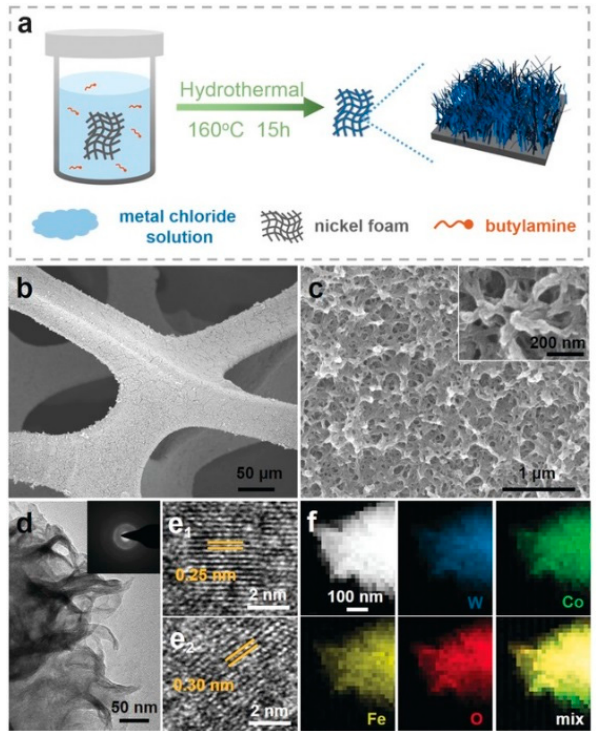
Figure 25. Preparative route ( a ) and morphological characterization of oxyhydroxides on nickel foam (NF): ( b , c ) SEM, ( d ) TEM and ( e 1 , e 2 ) HRTEM images of oxyhydroxide W 0.5 Co 0.4 Fe 0.1 /NF (inset: corresponding SAED pattern). ( f ) HAADF ‐ STEM image and STEM ‐ EDS mapping of W 0.5 Co 0.4 Fe 0.1 /NF (Co = green, Fe = yellow, O = red). Reproduced from [87], with permission from John Wiley and Sons, copyright 2017.